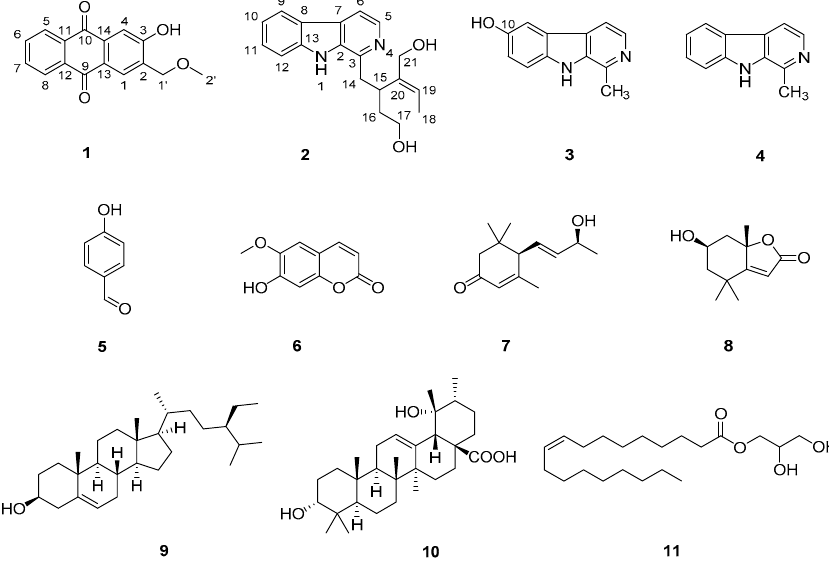
Figure 1. The chemical structures of compounds 1 – 11 obtained from O. japonica . Compound 1 was isolated as a yellow amorphous powder. Its molecular formula was established as C 16 H 12 O 4 by a ion peak at m / z 267.0660 [M-H] − (calcd. 267.0663 for C 16 H 11 O 4 ) in the HREIMS spectrum (Figure S1), indicating 11 degrees of unsaturation. The IR absorption at 3358 and 1658 cm − 1 suggested the presence of hydroxyl and carbonyl groups (Figure S8). The 13 C NMR, DEPT, and HSQC spectra (Figures S3 and S4) of 1 revealed 16 carbon signals, including one oxygenated methyl ( δ C 59.1), one oxygenated sp 3 methylene ( δ C 74.0), six sp 2 methines ( δ C 134.2, 133.9, 128.1, 127.3, 127.3, and 114.9), and eight sp 2 nonprotonated carbons (six carbons at δ C 162.0, 136.5, 133.8, 133.8, 128.2, and 126.5, two ketonic carbonyls at δ C 183.0 and 182.3) (Table 1). Six double bonds and two carbonyls accounted for eight of the eleven degrees of unsaturation; the remaining three degrees of unsaturation indicated that a tricyclic ring system belonged to the structure. Its 1 H NMR data (Table 1, Figure S2) revealed that compound 1 consist of an ortho-substituted benzene ring (ring A) at δ H 8.29 (2H, overlapped) and 7.78 (2H, overlapped), and a